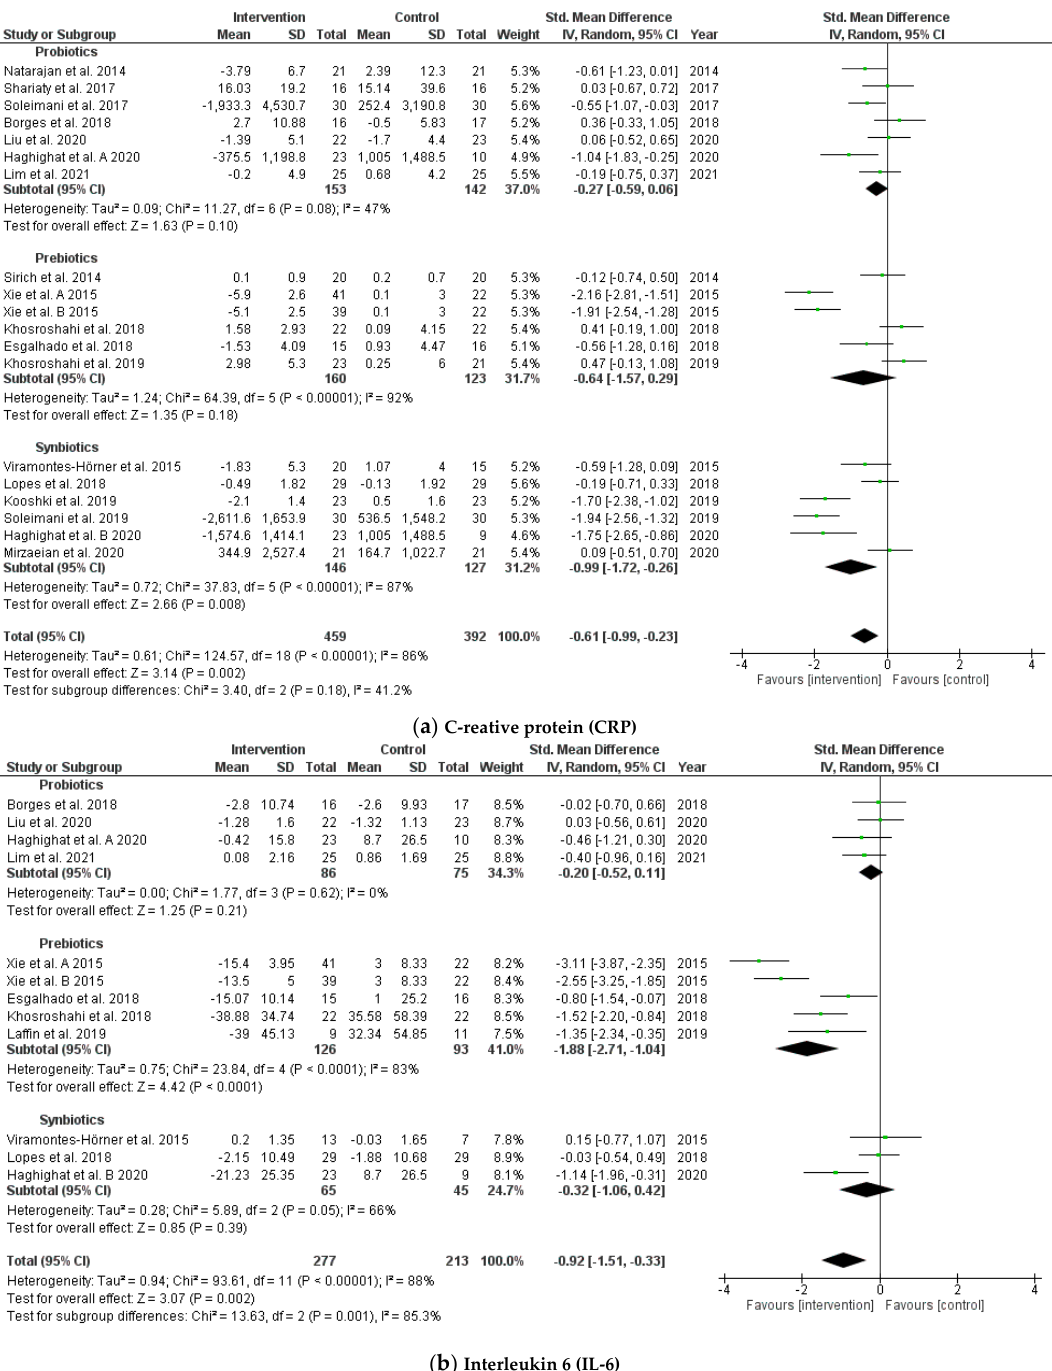
Figure 6. Forest plot for probiotic, prebiotic, and synbiotic effects on biomarkers of inflammation: ( a ) C-reative protein (CRP); ( b ) interleukin 6 (IL-6) in hemodialysis